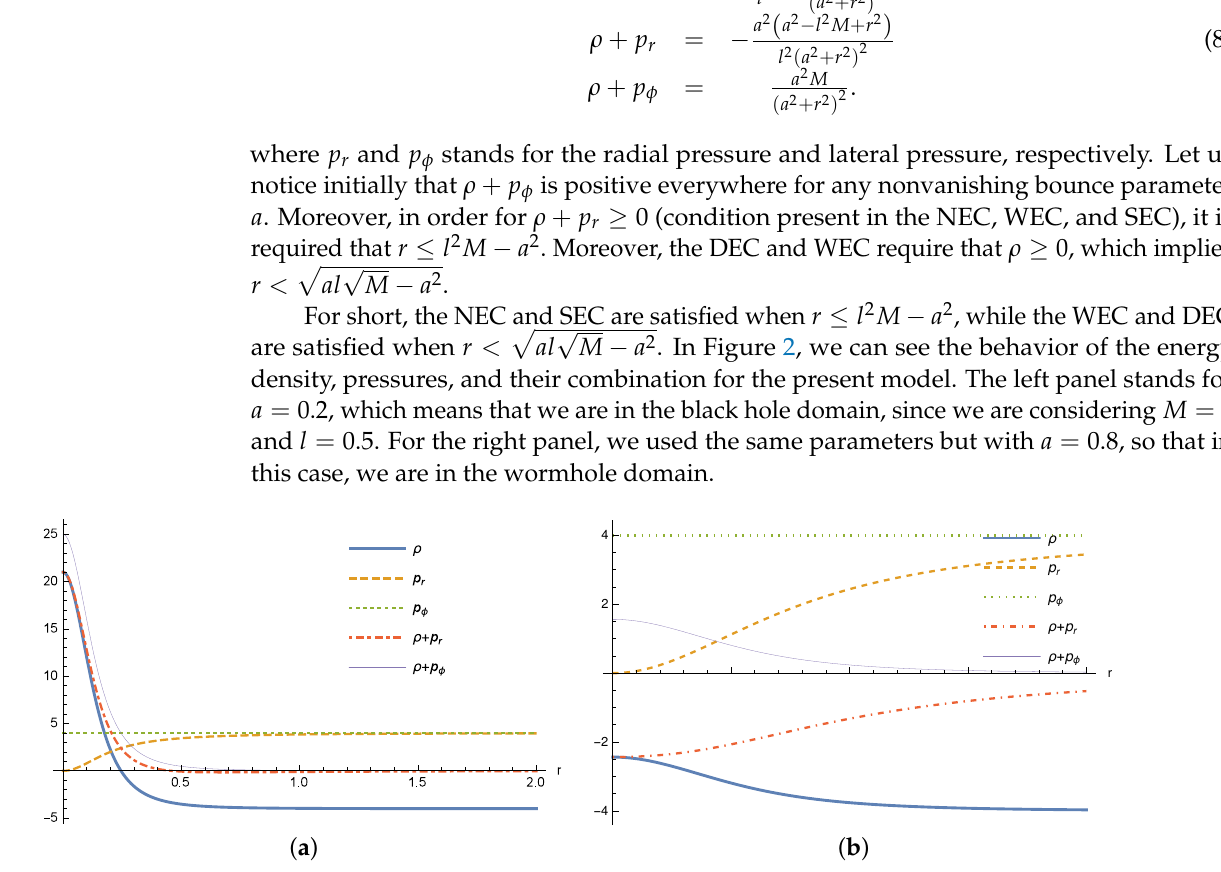
Figure 2. Behavior of the energy density, pressures, and their combination for the Simpson–Visser BTZ black hole. ( a ) stands for a = 0.2 while ( b ) is for a = 0.8. We used for this plot M = 1 and l =